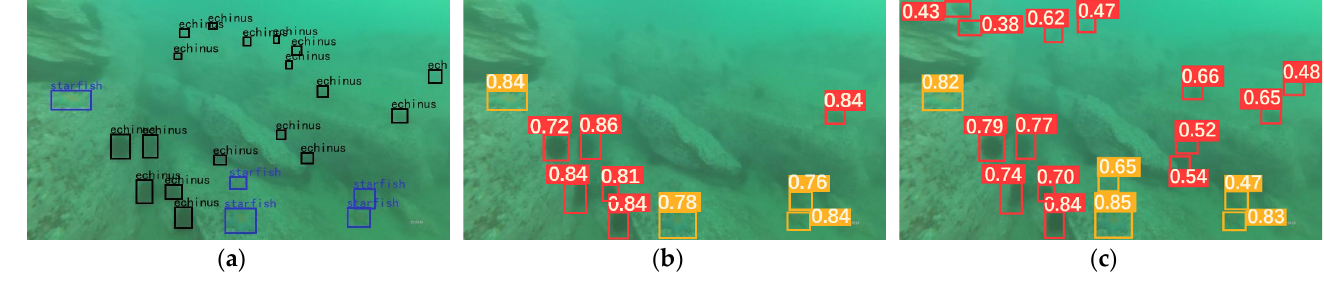
Figure 16. The comparison of detection results of some images in test set: ( a ) ground truth; ( b ) de- tection results of the baseline model trained without random expansion; and ( c ) detection results of the baseline model trained with random expansion. In ( b , c ), orange boxes represent starfish and red boxes represent echini.